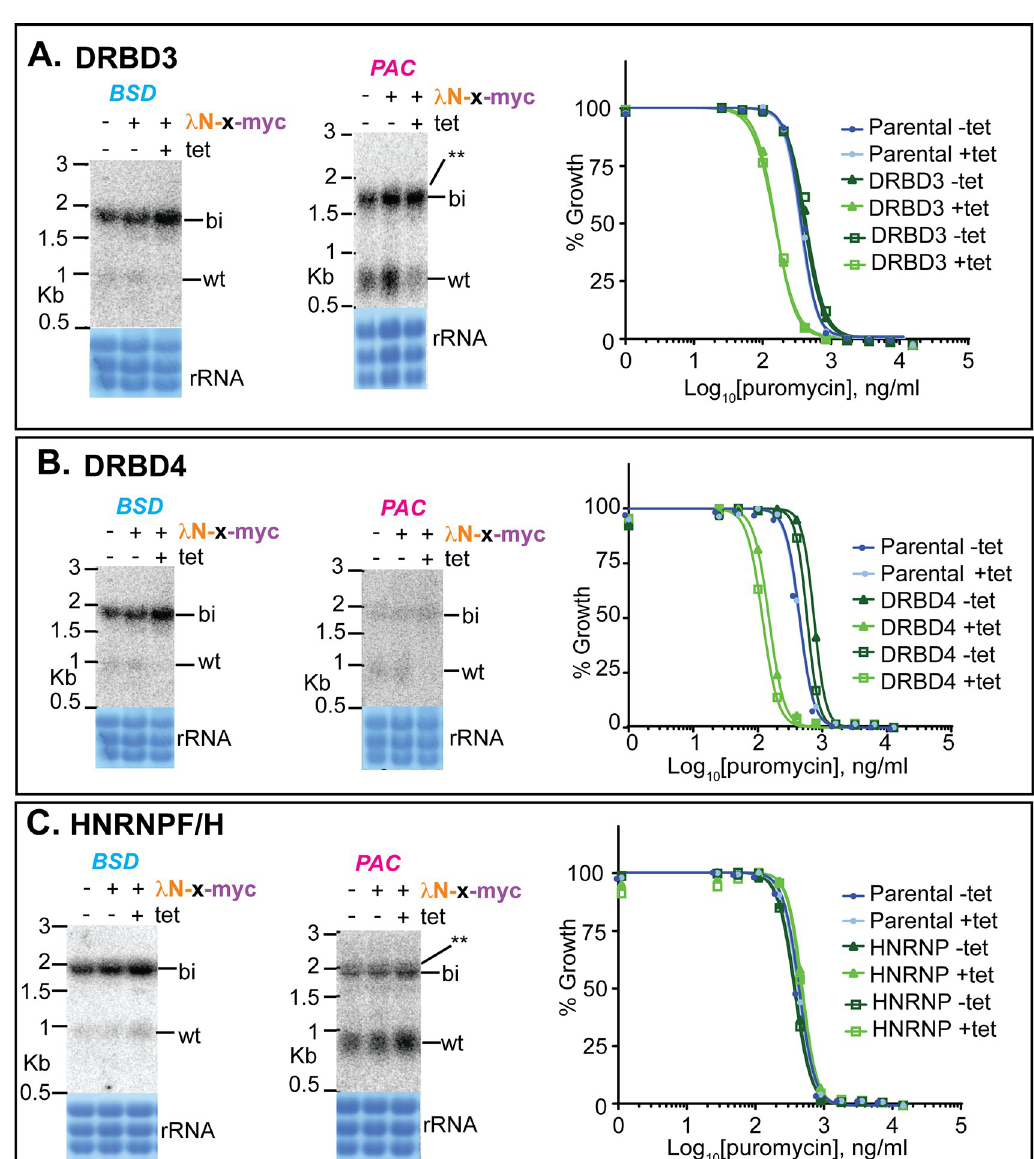
Fig 6. Effects of tethering (A) DRBD3, (B) DRBD4 or (C) HNRNPF/H to the boxB-(U) 3 reporter. Details are as for Fig 5. See also S1 and S4 Figs. level to around 11%, but there was also no effect on growth (Fig 10B). We compared the tran- scriptomes of two independent RBSR1 RNAi lines and three independent RBSR2 RNAi lines (Figs 10A and S10) with three replicates from the RBSR2-TAP starting line (chosen because the TAP tag alone had no effect on growth). For both RBSR1 and RBSR2, RNAi induction had no effect on the transcriptome (S8 Fig and S5 and S6 Tables). All of the RBSR RNAi lines showed accumulation of the RNAi-mediating RNA, which, from examination of the reads (E-MTAB-11627 and E-MTAB-11648), was trans spliced on the "sense" strand. We pooled the RNASeq results with and without tetracycline, since it made no difference, and compared the transcriptomes of the two lines with the starting (TAP-tagged) line for